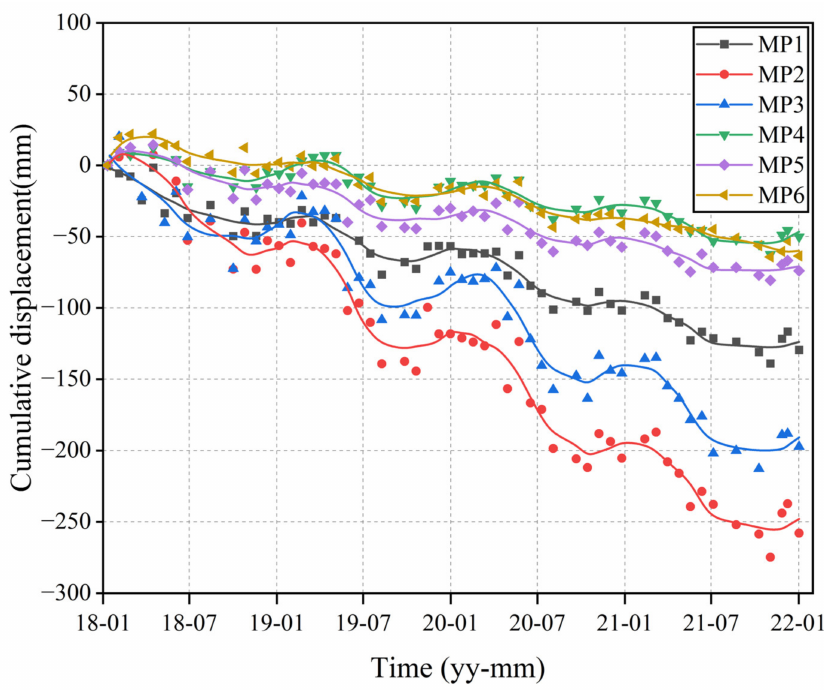
Figure 9. Cumulative displacement curves of Time-Series InSAR measurement points of the Sifangbei